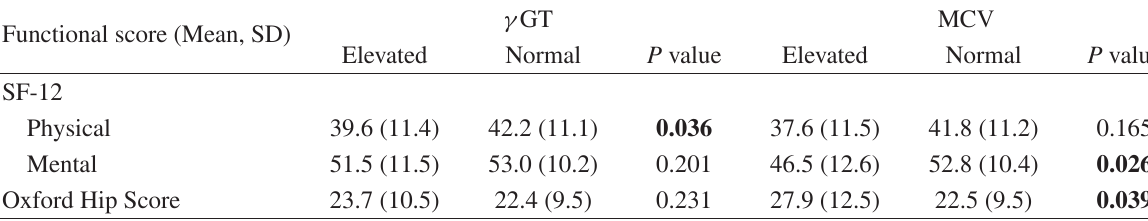
TABLE 2: Mean function scores at 1 year assessment in patients with normal and elevated biomarkers. Functional score (Mean, SD)